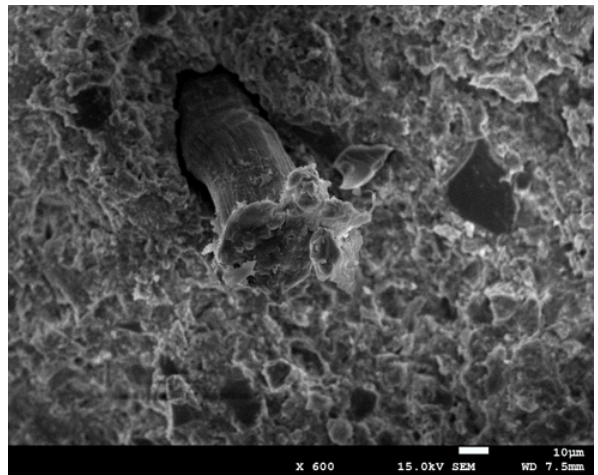
Figure 13: The interfacial transition zone between the PVA fibers and matrix.